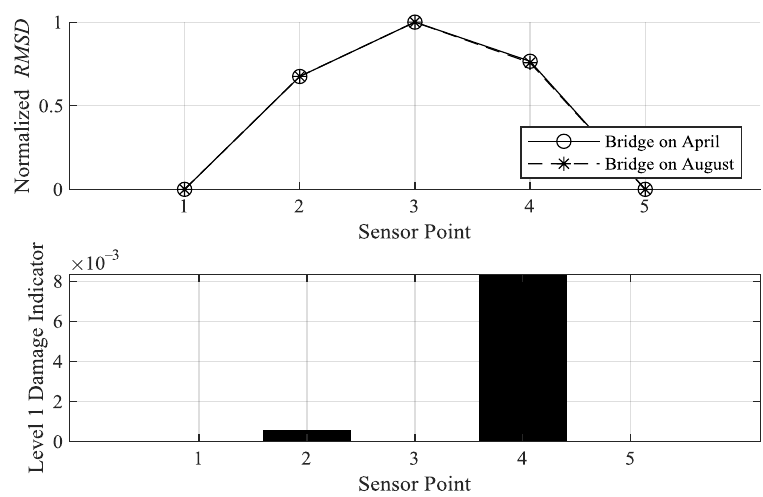
Figure 30. Level 1 damage indicator of Wenzhou bridge in August.